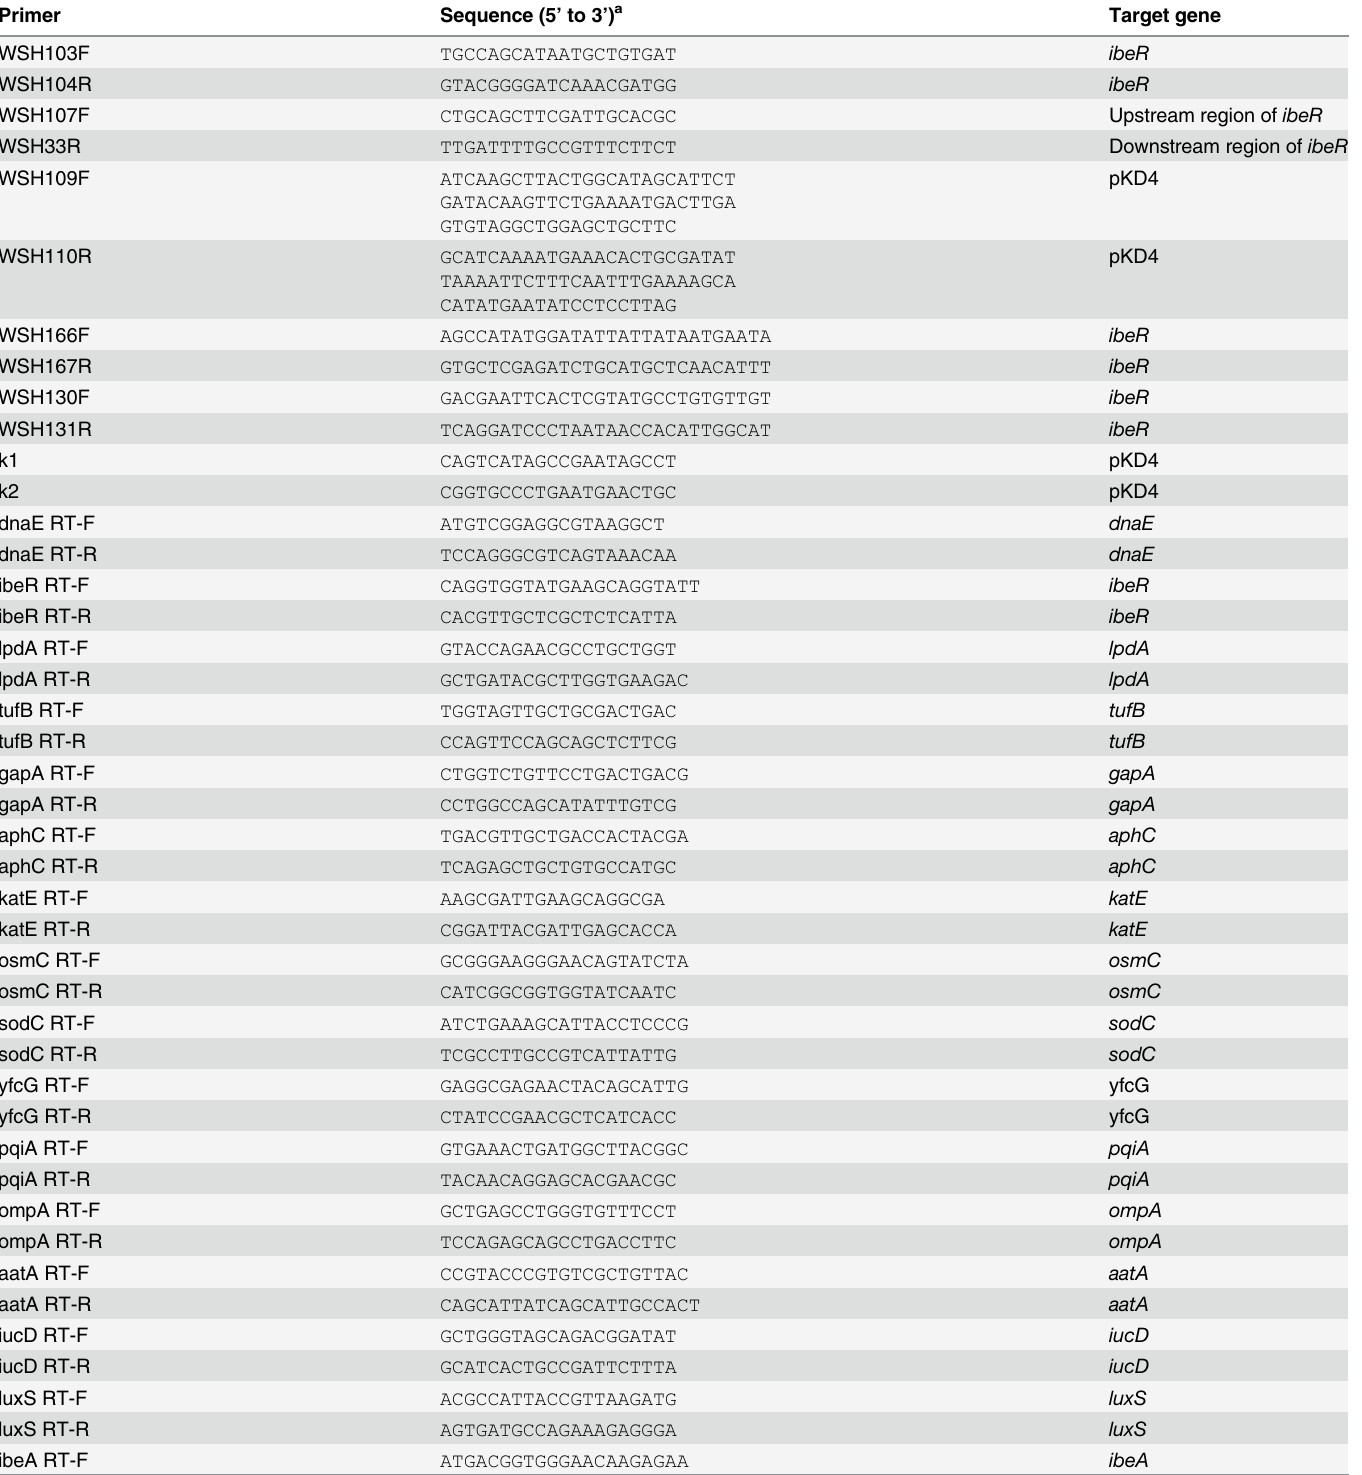
Table 2. Primers used in this